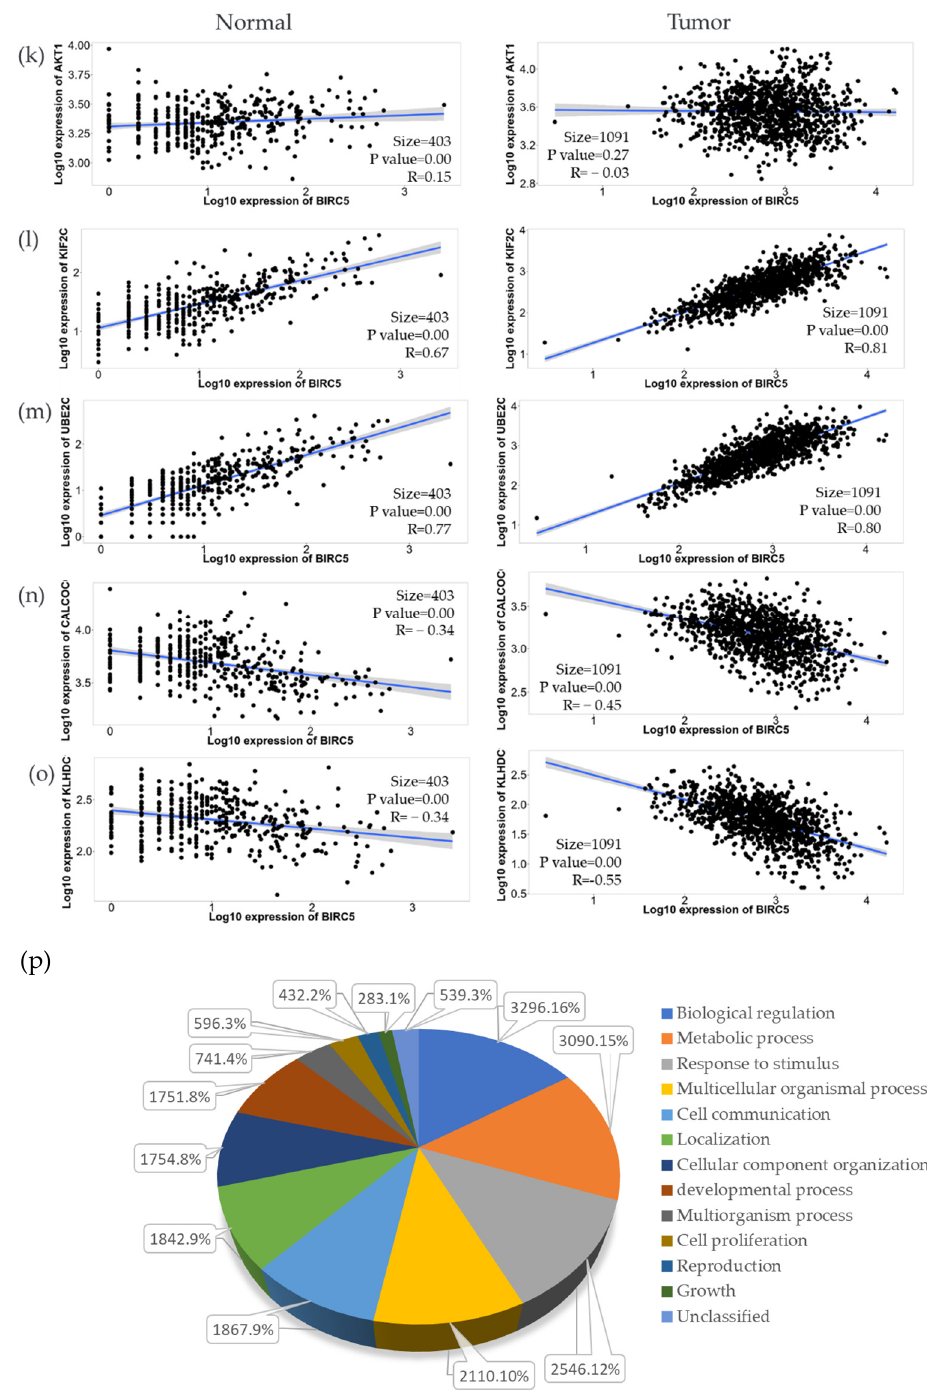
Figure 12. BIRC5 targets gene expression in breast cancer. ( a , b ) A heatmap created by UALCAN analysis shows how the anticipated BIRC5 target genes are expressed (Ualcan.path.uab.edu/analysis (accessed on 4 July 2022)). ( c – j ) The most notable targets implicated in cancer suppression, progression, or carcinogenesis, as well as those previously identified, had significant alterations in BC compared to normal. ( k – o ) The correlation between BIRC5 and target genes. ( p ) A pie chart featuring biological processes in which target genes are components, generated using PANTHER (http://www.pantherdb.org (accessed on 1 July 2022)).